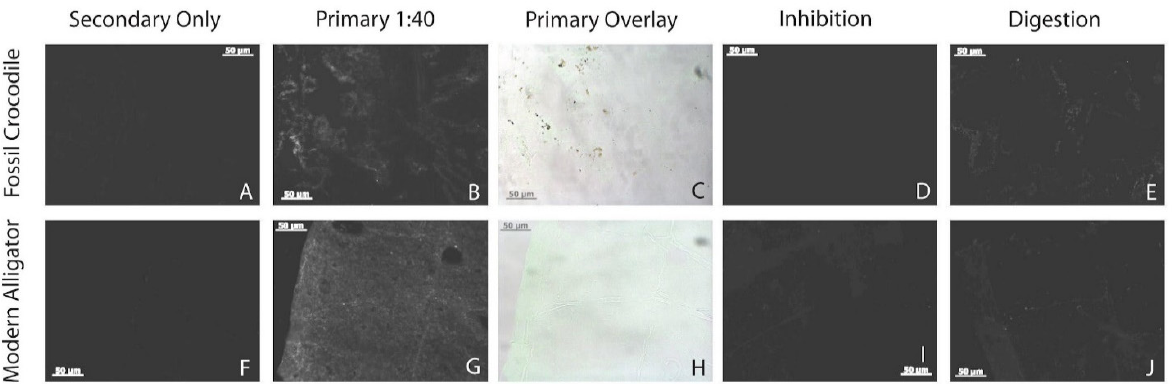
Figure 7. In situ immunofluorescence results for fossil and modern Alligator samples. All sections imaged at 200 ms exposure. ( A , F ) Secondary only negative-control tissue sections never exposed to primary antibodies; ( B , G ) tissue sections incubated with anti-chicken collagen I antibodies at 1:40 concentration; ( C , H ) overlays of fluorescence images in ( B , G ) on light microscope images, showing localization of fluorescence to tissue within sections (fluorescence shown as green coloration); ( D , I ) tissue sections treated with the same anti-chicken antibodies but exposed to Alligator collagen prior to incubation with sections (“inhibition control”); ( E , J ) tissues sections incubated with collagenase for 3 h prior to incubations with the same primary antibodies. Negative controls and specificity controls exhibit reduced or absent signals, indicating a lack of spurious binding and the presence of endogenous collagen I in each bone sample. Scale bars as indicated.